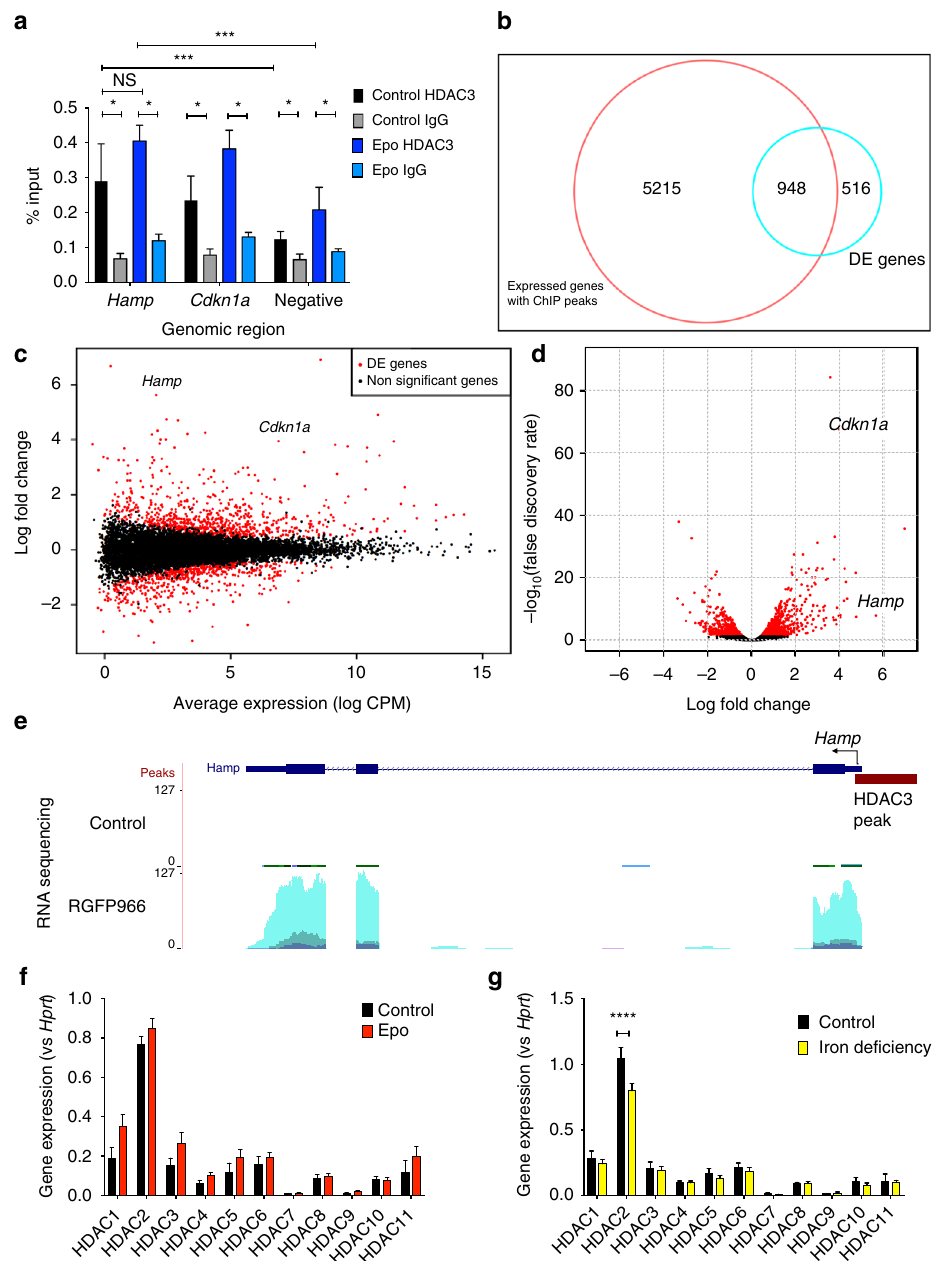
Fig. 9 Enrichment of HDAC3 at the hepcidin locus and effects of HDAC3 inhibition on genome-wide RNA expression pro fi le. a Six-week-old C57Bl/6 male mice were administered Epo daily for 3 days 200 IU i.p. or control. ChIP-qPCR for HDAC3 (compared with IgG isotype control) at the hepcidin gene locus, along with the Cdkn1a locus as a positive control and a negative control genomic region. N = 3, paired t -tests. RNA sequencing of livers from mice treated with 3 weeks low-iron diet followed by either vehicle or two doses of RGFP966. Three biologic samples (those with the highest quality RNA) were selected for sequencing from each group. b Smear plot (log fold change vs expression levels), highlighting Hamp and Cdkn1a genes. c Volcano plot ( P -value vs log fold change) highlighting Hamp and Cdkn1a genes. d HDAC3 ChIP-Seq peaks were annotated and compared to differentially expressed genes. Expression of each HDAC in 6-week-old mice treated with e Epo vs control, and f ID vs control. Signi fi cance testing adjusted for multiple comparisons. N = 8 per group, same mice as experiments presented in Fig.